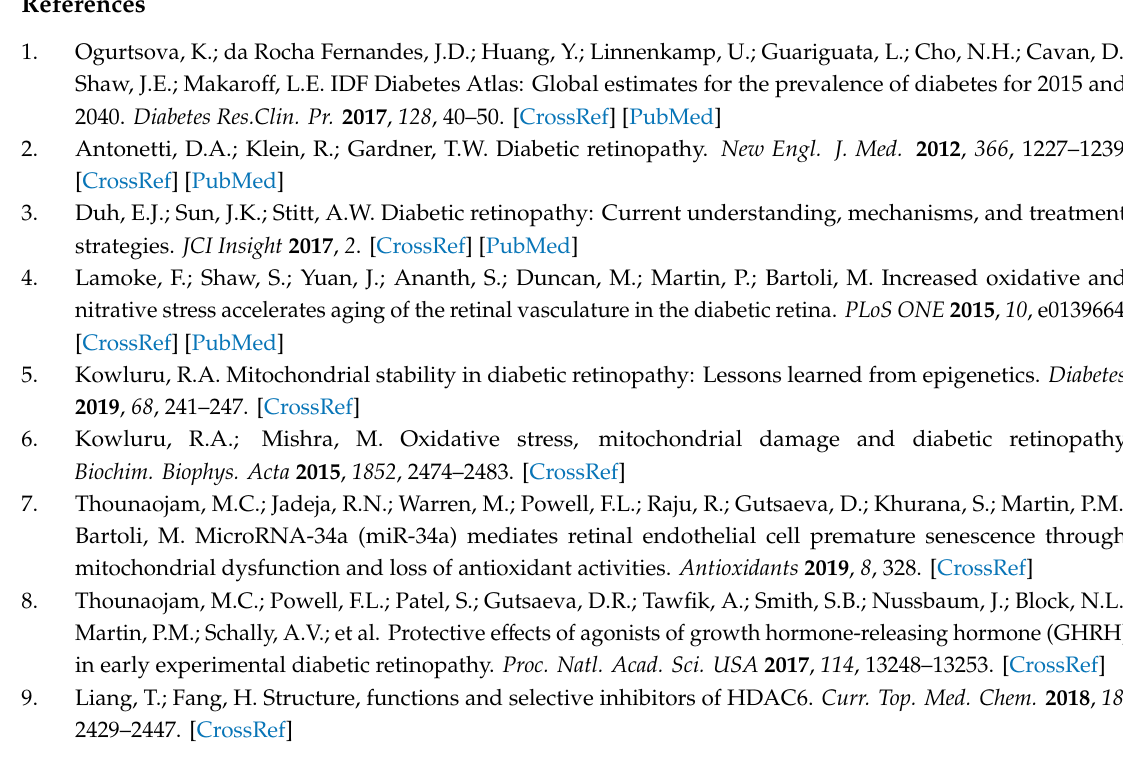
Table S1: Demographics and clinical history of human postmortem retinal donors. Table S2: Biochemical parameters measured in the experimental rat groups. Table S3: Primer sequences used in the study. Figure S1: MTT